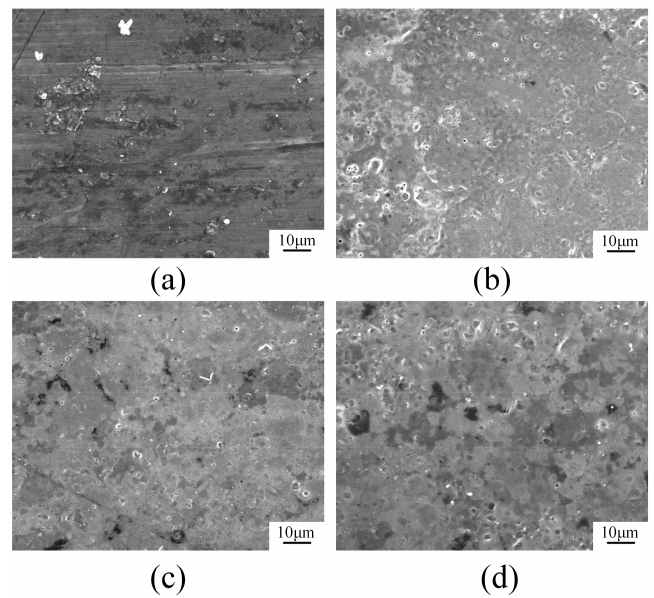
Figure 7. SEM surface microstructure of aluminum alloy Cleaned at di ff erent cleaning speeds: ( a ) Reference sample; ( b ) 10.4 mm / s; ( c ) 4.1 mm / s; ( d ) 1.0 mm / s.